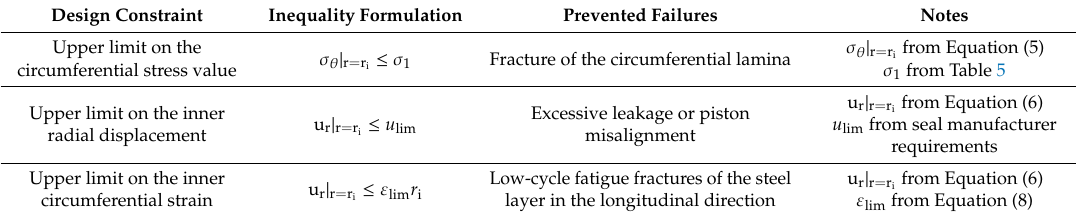
Table 6. The three design constraints discussed in the present paragraph, for summarizing purposes. Design